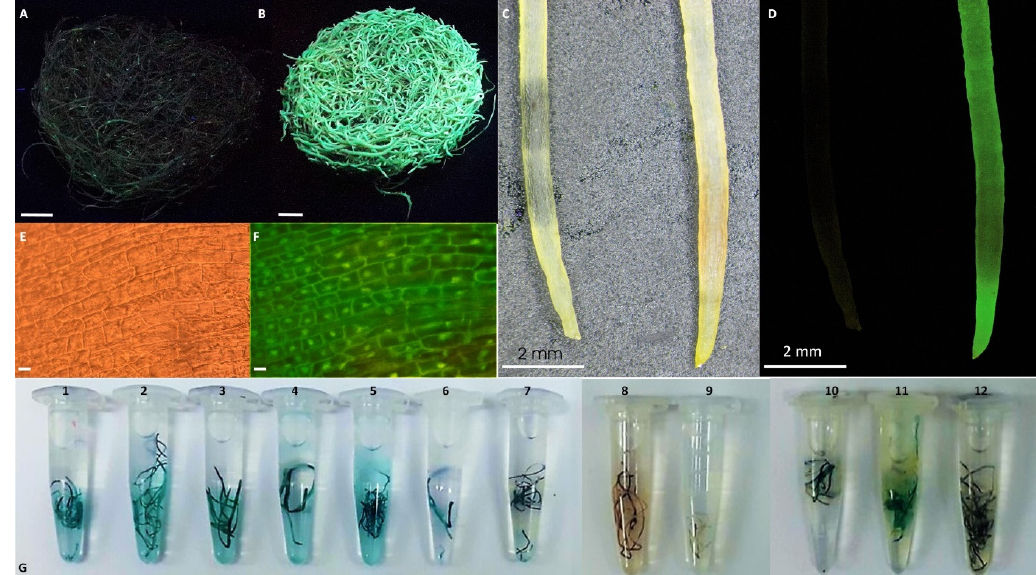
Figure 4. GFP fluorescence detection and histochemical analysis of β -glucuronidase activity in transgenic hairy root lines. ( A )-SOPSS hairy roots in UV light, ( B )- SOGFP hairy roots in UV light, ( C )- SOPSS (left) and SOGFP (right) roots in white light, ( D )- SOPSS (left) and SOGFP (right) roots in UV light, ( E )-optical and ( F )- fluorescence microscope images of SOGFP hairy root tissue, ( G )- b-glucuronidase activity test of: 1-7—SOPSS 1-7; 8-9—SOA41,2; 10-12—SOGFP 1-3 hairy root lines. bar: A,B = 1cm, EF = 50µm.